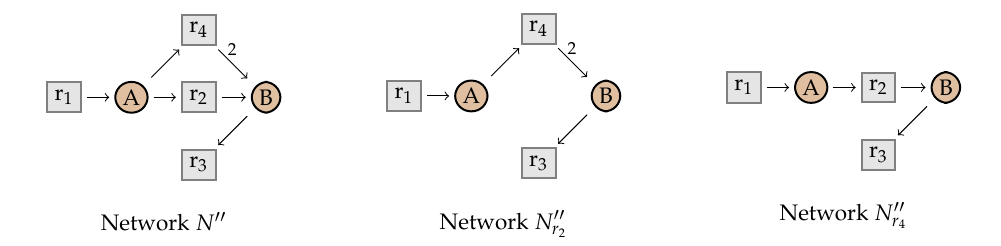
Figure 8. Dependency elimination is not